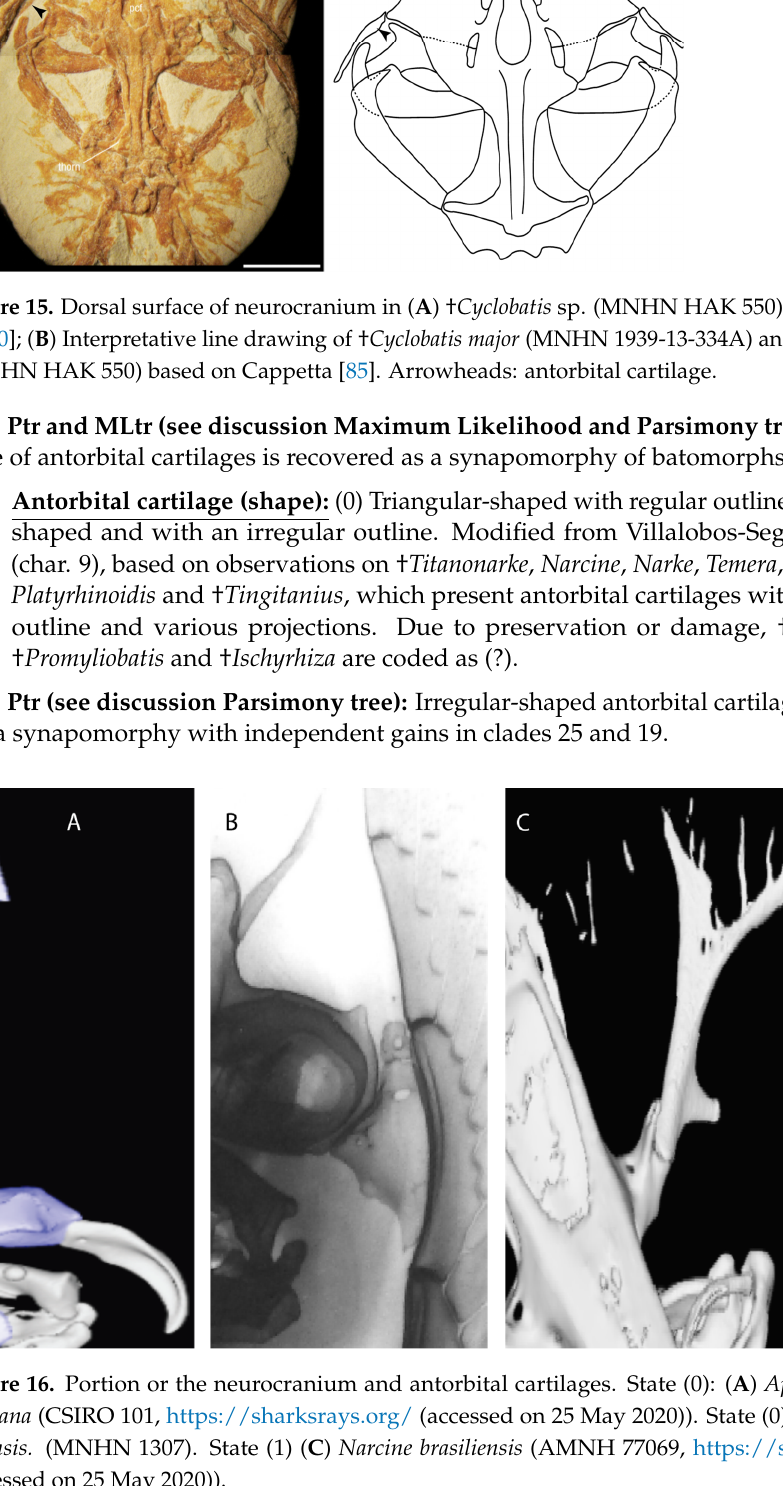
sinensis. (MNHN 1307). State (1) ( C ) Narcine brasiliensis (AMNH 77069,